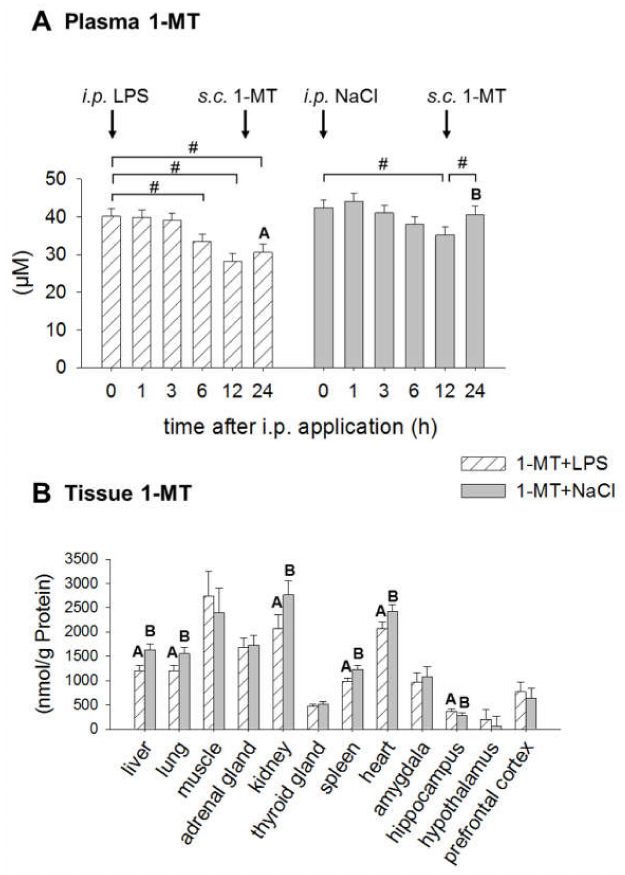
Figure 3. Effects of LPS on 1-MT concentrations in plasma ( A ) and tissues ( B ). Treatment with NaCl was used as a control. MYR-pre-treated animals are not shown due to the absence of 1-MT. 1-MT was quantified using MS/MS. LPS or NaCl (indicated by black arrows) were injected i.p. directly after blood sampling at 0 h. The animals received the fifth s.c. 1-MT injection at 12 h after LPS/NaCl treatment as indicated. The data are presented as LS-means ± SE. In plasma ( A ), significant differences between the time points were calculated using the Tukey–Kramer test and indicated by hashes within each treatment group. Significant differences between LPS and NaCl groups ( p < 0.05) are indicated using differing letters (A, B). For time points 0, 1, 3, 6 h: n = 12/group. For time point 24 h: n = 6/group. The data for 1-MT in tissues ( B ) include both sampling times (6 and 24 h, n = 12/group) after i.p. application. Significant differences between LPS and NaCl treatment were calculated using the Tukey–Kramer test and are indicated for each tissue, respectively. # p <